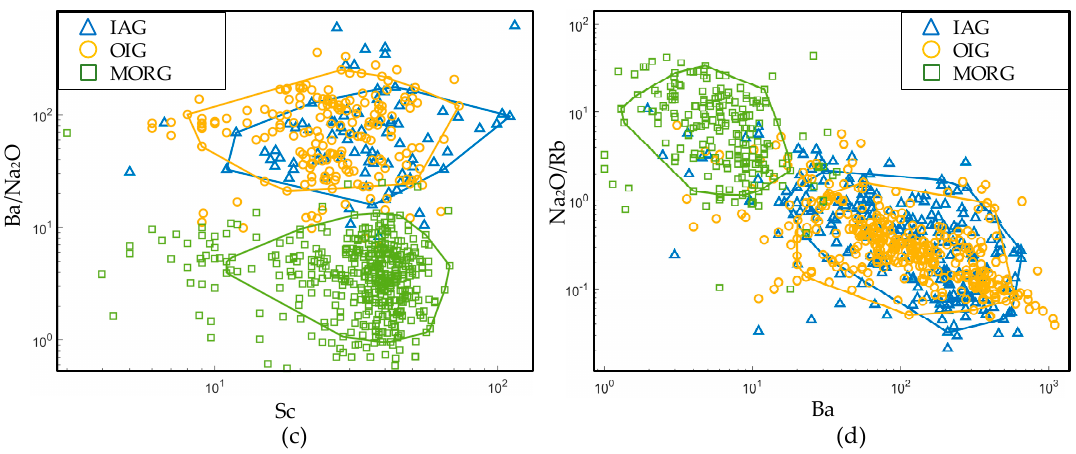
Figure 17. Discrimination diagrams for MORG and non-MORG. All four diagrams have a 0.85 confidence region. ( a , b ) are in linear coordinates; ( c , d ) are in logarithmic coordinates.